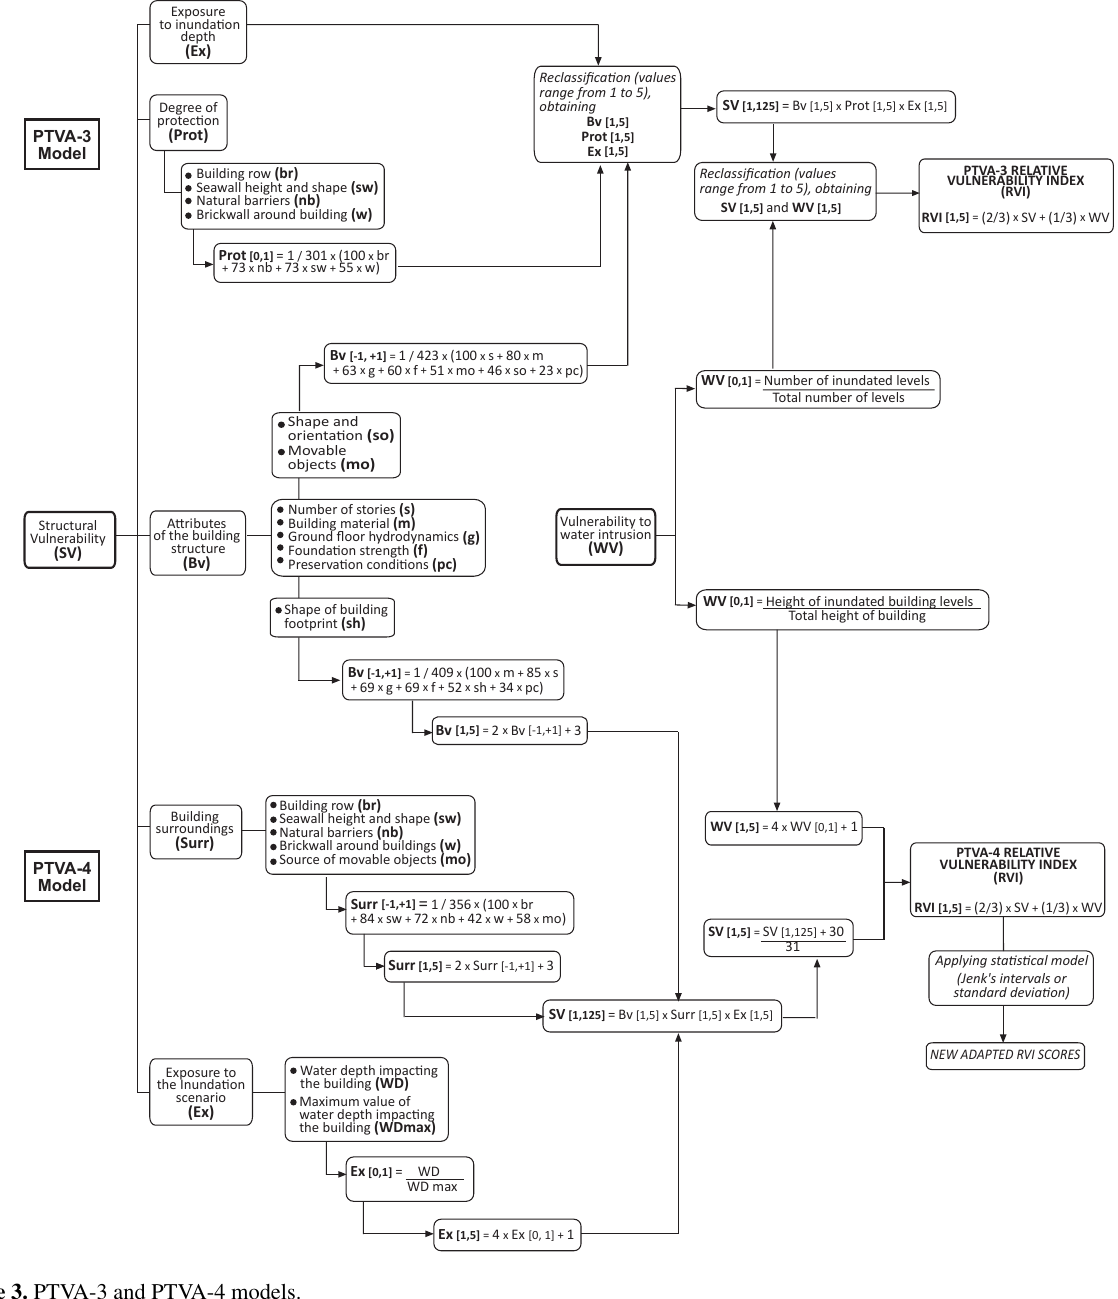
Figure 3. PTVA-3 and PTVA-4 models. Table 2. Original parameter ( m ) (Dall’Osso et al., 2009a) and modified according to the constructions of northern